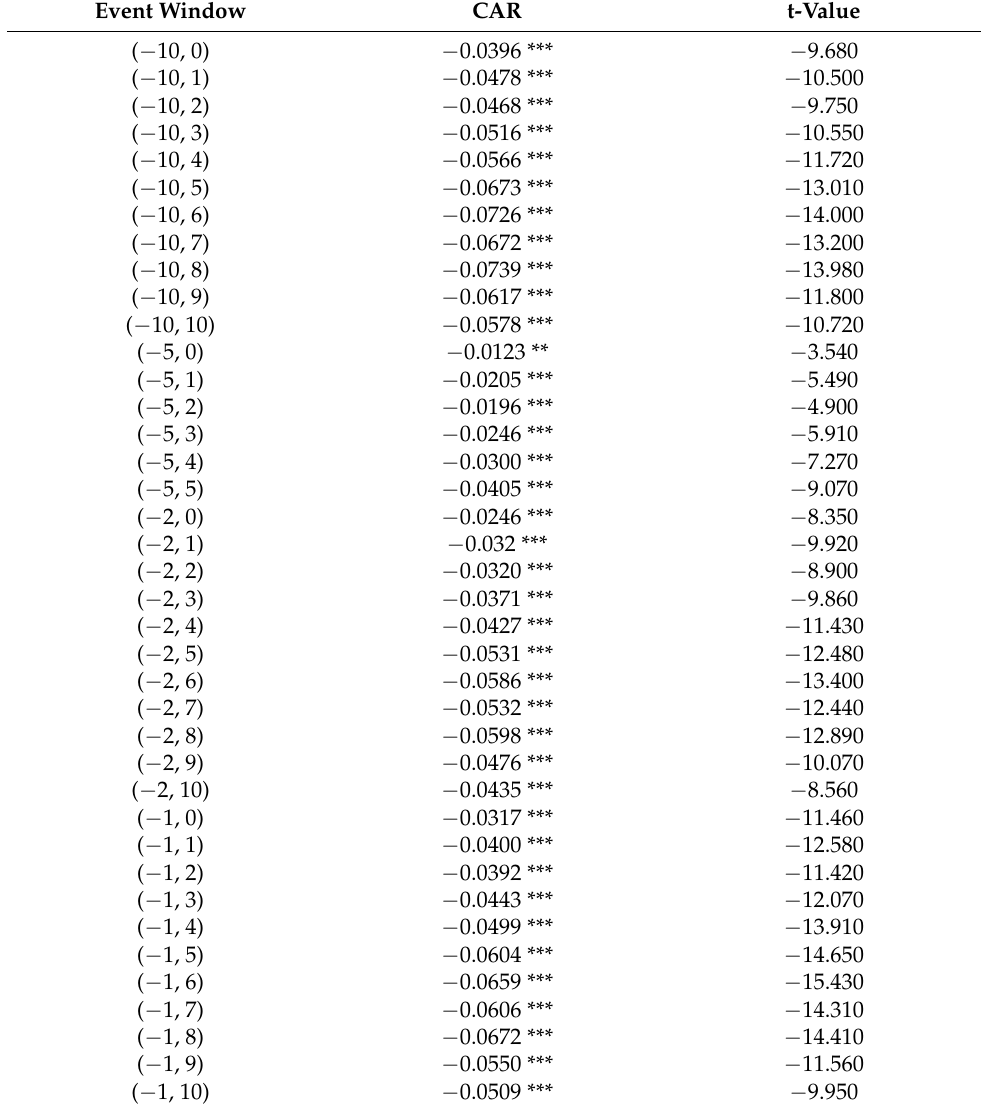
Table 1. t -test of